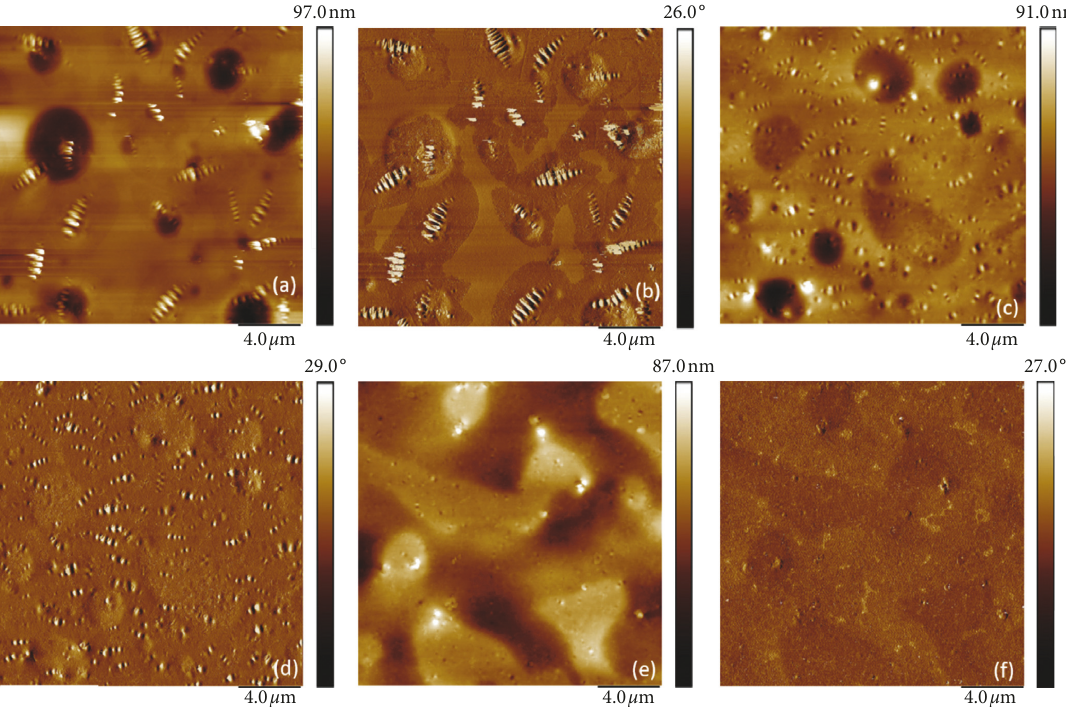
Figure 12: AFM images of rubberized PMA binders with SIS. (a) Topographical image of GTR0%. (b) Phase image of GTR0%. (c) Topographical image of GTR5%. (d) Phase image of GTR5%. (e) Topographical image of GTR10%. (f) Phase image of